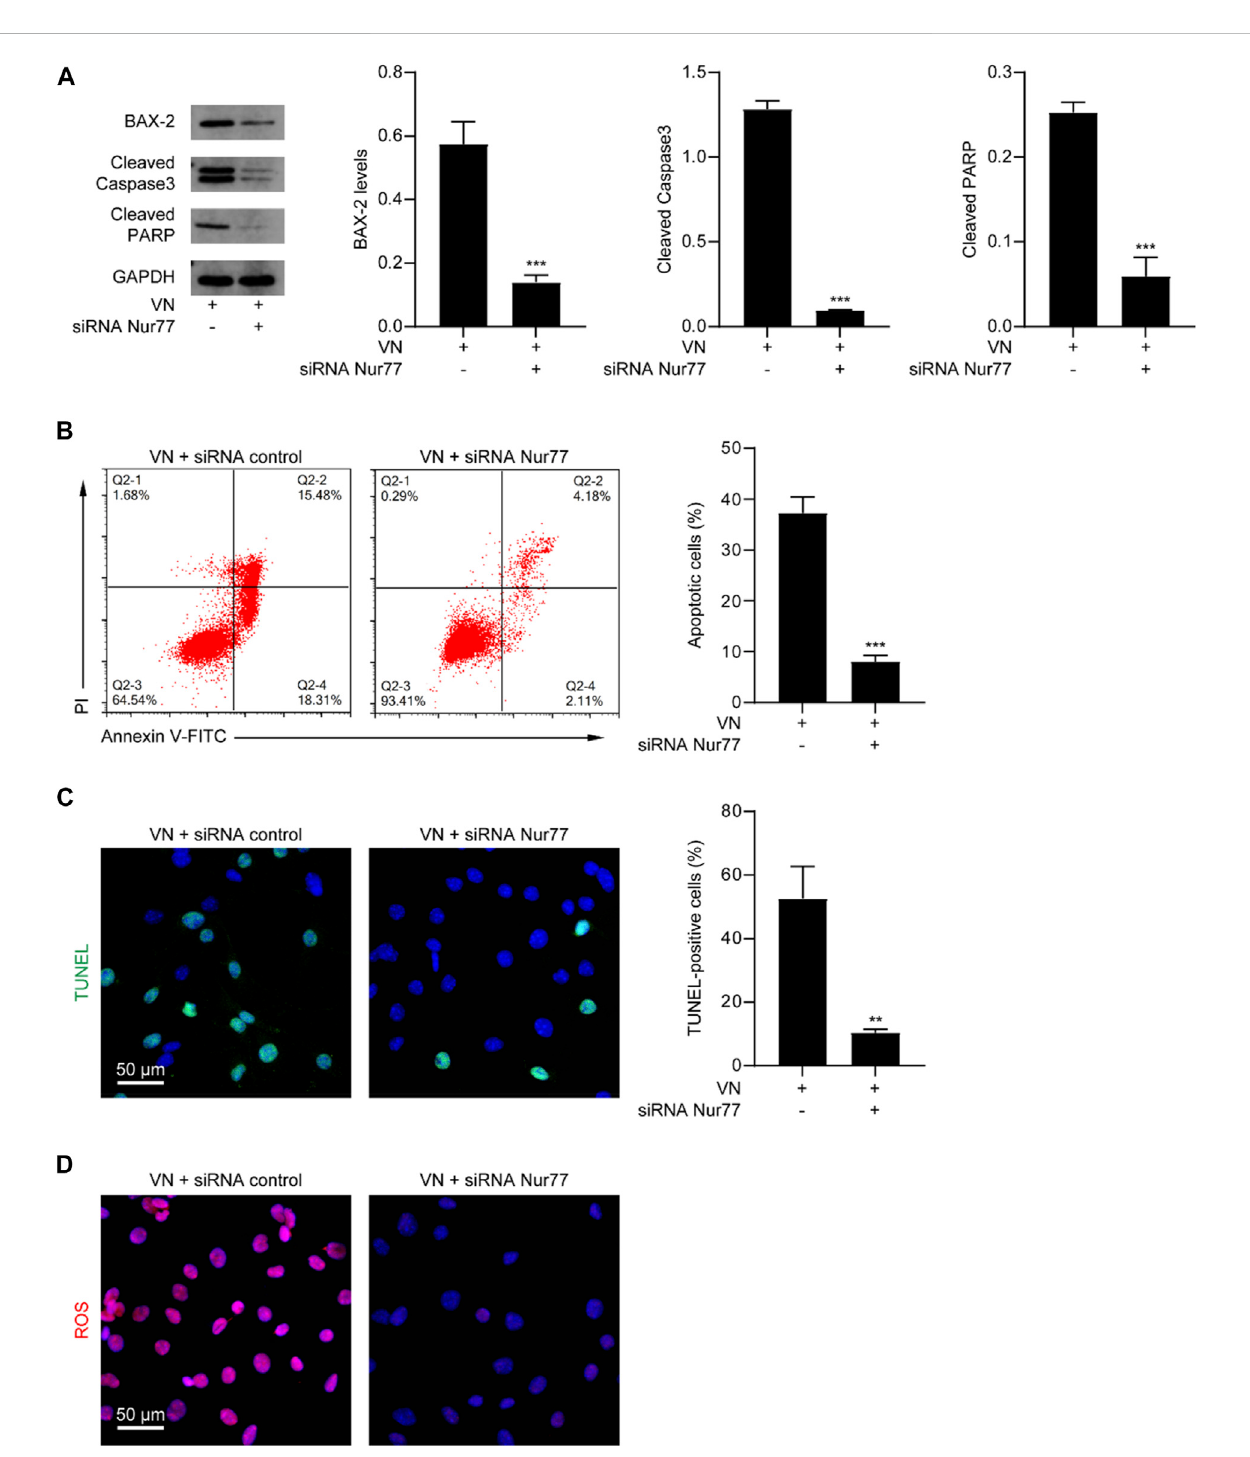
FIGURE 4 Nur77 expression was necessary for venlafaxine-induced apoptosis. MV3 cells were transfected with siRNA control or Nur77 siRNA, following by treatmentwithvenlafaxine(10 μ M)for0 – 8 h. (A) TheproteinexpressionofBAX-2,caspase3andcleavedPARPinMV3cellswasdetectedbywesternblot.Inte cleaved nsity of the protein bands was quanti fi ed and normalized to loading control GAPDH. (B) Apoptosis assays in MV3 cells were conducted by fl ow cytometry. (C) The apoptotic cells were detected by TUNEL assay. (D) MV3 cells treated with the cellular ROS assay kit and visualized by confocal microscopy. N = 3, **, p < .01, ***, p < .001 vs.